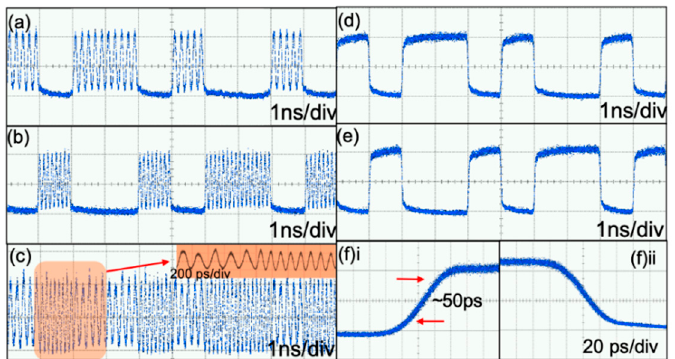
Figure 13. ( a ) and ( b ) Temporal waveforms of only 5 GHz or 8 GHz RF signals when a hopping code sequence of “1011010010” is used in the FWM RF switch; ( c ) Generated frequency-hopping signal between 5 GHz and 8 GHz from FWM RF switch controlled by a “1011010010” code sequence, inset: zoom-in waveform of the orange shaded area; ( d ) and ( e ) FWM outputs at x - and y -polarization when no RF signals are used; ( f ) Response time measurement for (i) Rising and (ii) Falling